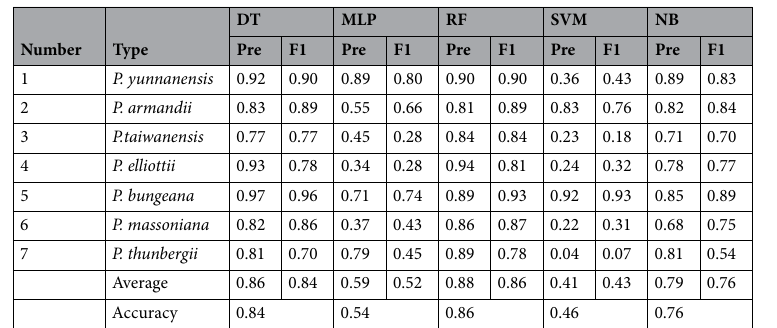
Table 4. Precision and F1 scores of five pine nut classification models with non-normalized NIR spectral data.